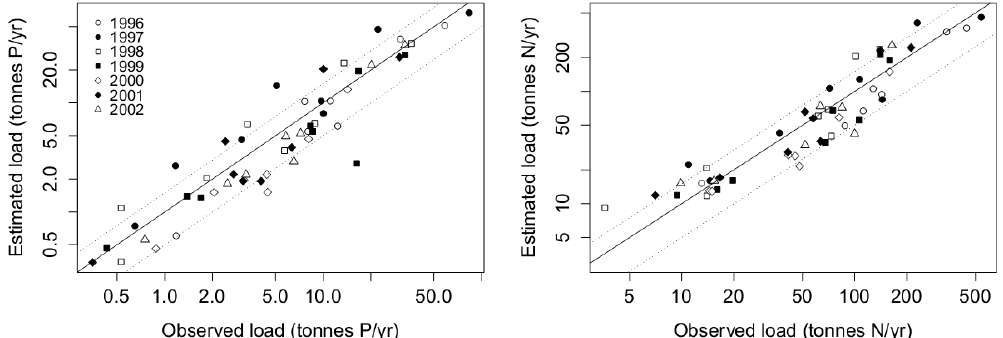
Fig. 4. Plots of modelled versus observed values of total phosphorus and total nitrogen for the different years of the study period. The dashed lines represent a 50% deviation.